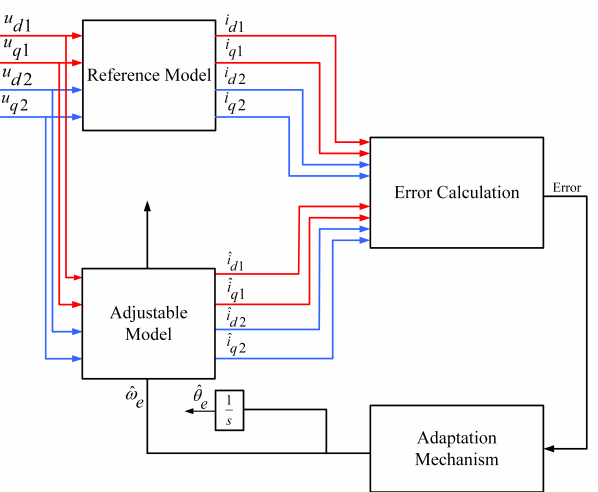
Figure 6. Block diagram of MRAS [31].